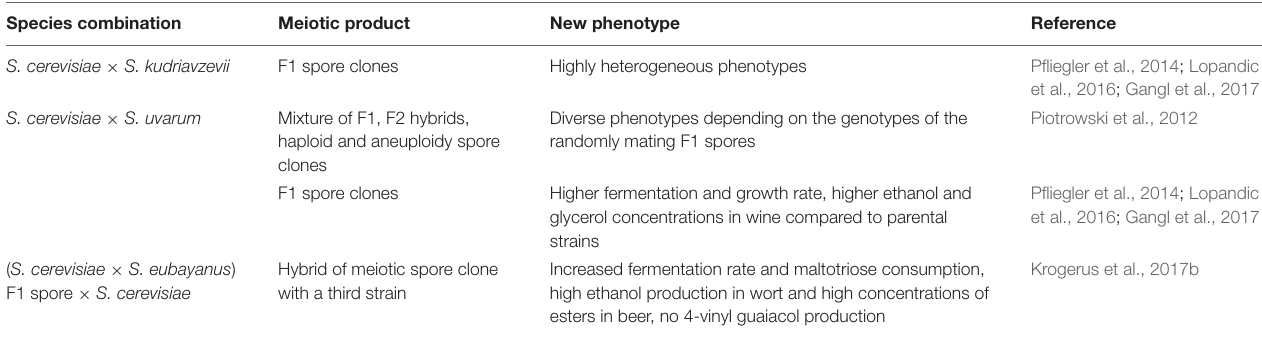
TABLE 3 | Examples of meiotic segregants of interspecies hybrids. Species